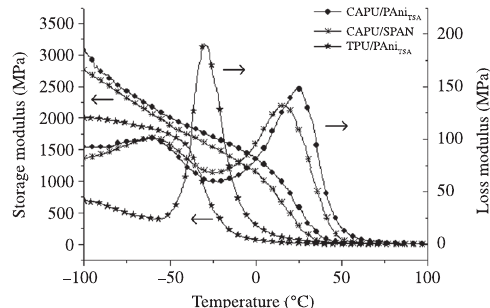
Figure 7. Storage and loss moduli of TPU/PAni and CAPU/PAni